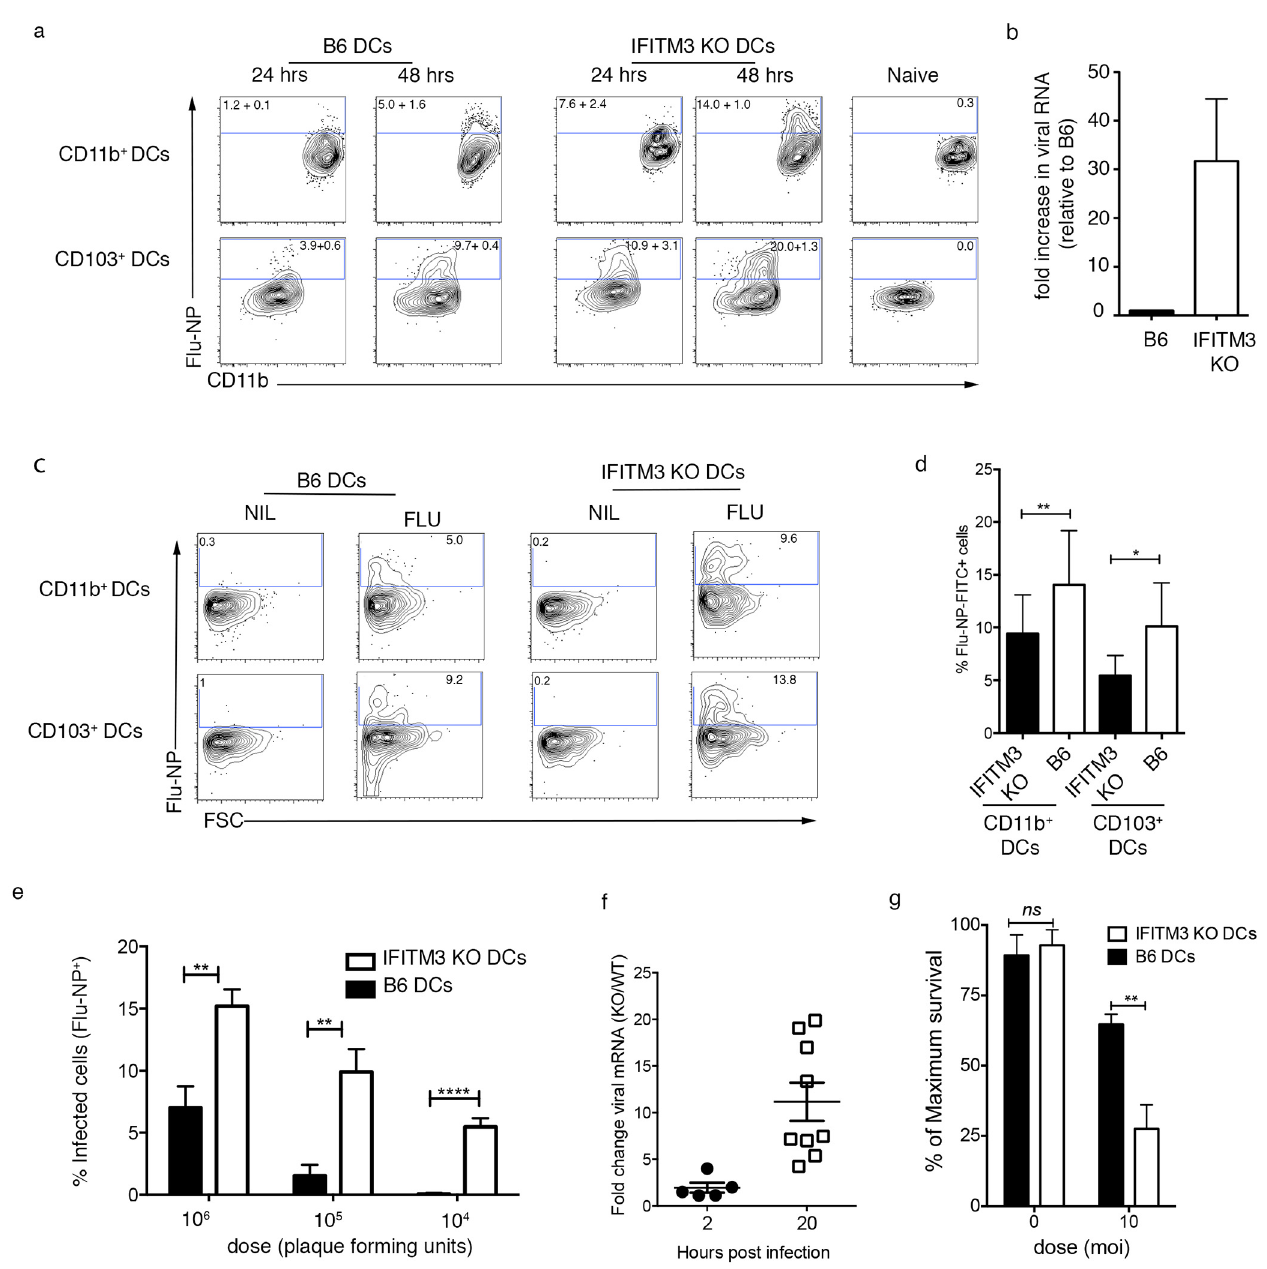
Fig 2. IFITM3 KO DCs are more susceptible to influenza virus infection. (a) B6 or IFITM3 KO mice were infected via the intranasal route with 10 4 PFU of influenza virus (Pr8) and 24 or 48 hrs later mice were culled and single cell preparations of lung cells were stained for expression of viral NP. The proportion of lung DCs staining positive for influenza virus NP was then determined by flow cytometry. Representative flow cytometry plots are shown (n = 4 – 6 mice, data pooled from 3 independent experiments, numbers represent mean + sem) (b) Dendritic cells (CD11c+MHCII+ F4/80-) were sort purified from the lungs of with B6 or IFITM3 KO mice 48 hrs after intranasal infection with 10 4 PFU of influenza virus (Pr8). The total amount of viral RNA present in the DC population was measured by real time PCR. Data are pooled from 3 independent experiments. Graph represents the fold increase in viral RNA normalized to the amount of viral RNA present in the B6 DCs. (c-d) CD103+ and CD11b+ DC were sort purified from the lungs of B6 or IFITM3 KO mice infected with influenza virus (moi 10) and cells were fixed 24 hr later, stained for influenza virus NP and examined by flow cytometry. (c) Representative flow cytometry profiles are shown. Data is representative of 3 independent experiments. (d) Graph depicts the mean percent infection + sem (data is pooled from 3 independent experiments, Student ’ s t test, ** P < 0.01, *** P < 0.001) (e) DCs were sort purified from the spleens of B6 and IFITM3 KO mice and monolayers of cells were infected with influenza virus at the doses indicated. At 12 hr post-infection, cells were fixed and stained for expression of viral NP and the percentage of infected cells was determined in at least 5 random fields ( > 200 cells). Data show the mean percent infection + sem (data is pooled from 3 independent experiments, Student ’ s t test, ** P < 0.01, *** P < 0.001, **** P < 0.0001) (f) Bone marrow derived B6 or IFITM3 KO DCs were infected with IAV (moi 1) and 2 and 20 hours later the amount of viral mRNA was measured by qRT-PCR. Graph represents the fold increase in viral RNA in IFITM3 KO DCs